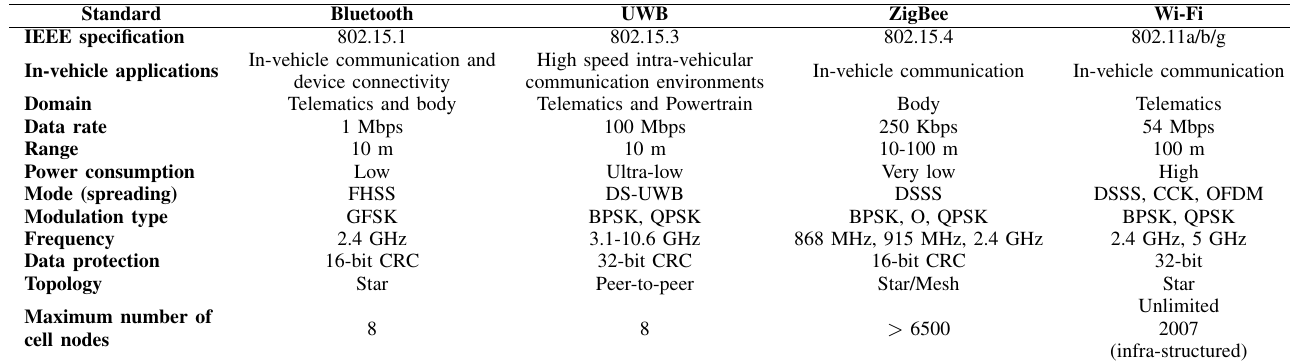
Fig. 7. Example for the application of an in-vehicle communication, based on [65]. TABLE III T HE MOST COMMONLY USED TECHNOLOGIES FOR IN - VEHICLE NEWTWORKS . A DAPTED FROM [66],